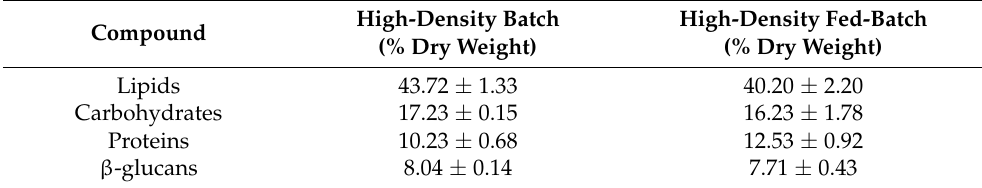
Table 2. Biochemical parameters 4 days after nitrogen depletion in culture medium.